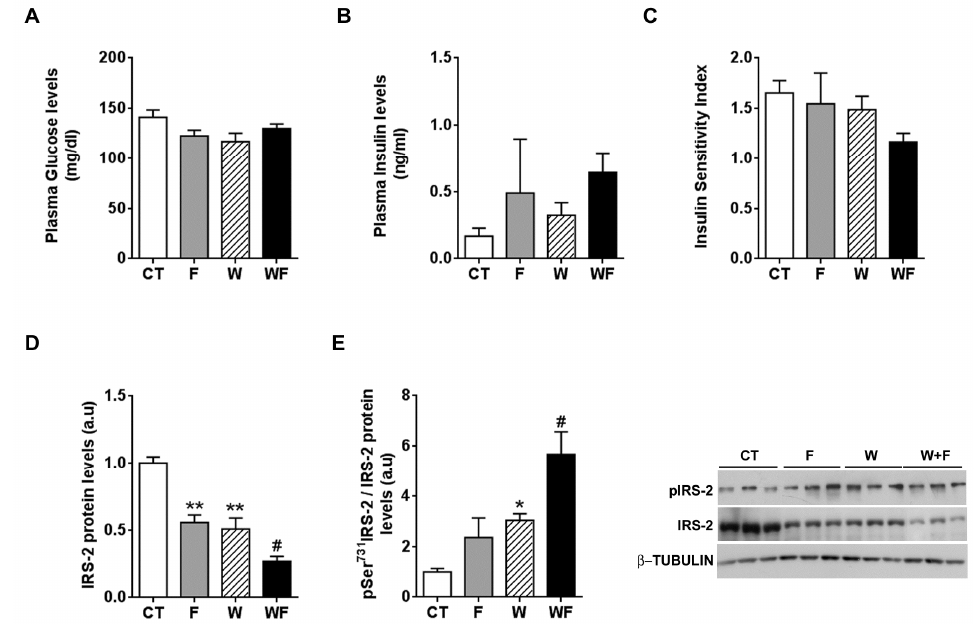
Figure 5. Insulin receptor signalling under basal conditions. Glucose ( A ) and insulin ( B ) plasma levels from Control (CT, mice fed standard solid ‐ chow), Fructose (F, mice fed standard solid ‐ chow plus a 15% fructose solution ad libitum), Western (W, mice fed Western solid ‐ chow), and Western + Fructose (WF, mice fed Western solid ‐ chow plus a 15% fructose solution ad libitum), expressed as mean ± SEM of 9–10 different samples; ( C ) Insulin Sensitivity Index (ISI), calculated as [2/(blood insulin (nM) × blood glucose ( μ M) + 1]; Western ‐ blot of total and phosphorylated IRS ‐ 2 ( D , E ) proteins in liver samples obtained from the different experimental groups under basal conditions. Representative bands corresponding to three different mice in each group are shown; bar plots show the level of total IRS ‐ 2 expressed as the mean (a.u., arbitrary units) ± SEM of the values obtained from three to four animals, and the ratio between phosphorylated and total IRS ‐ 2. * p < 0.05 and ** p < 0.01 vs. CT values; # p < 0.05 vs. W values.